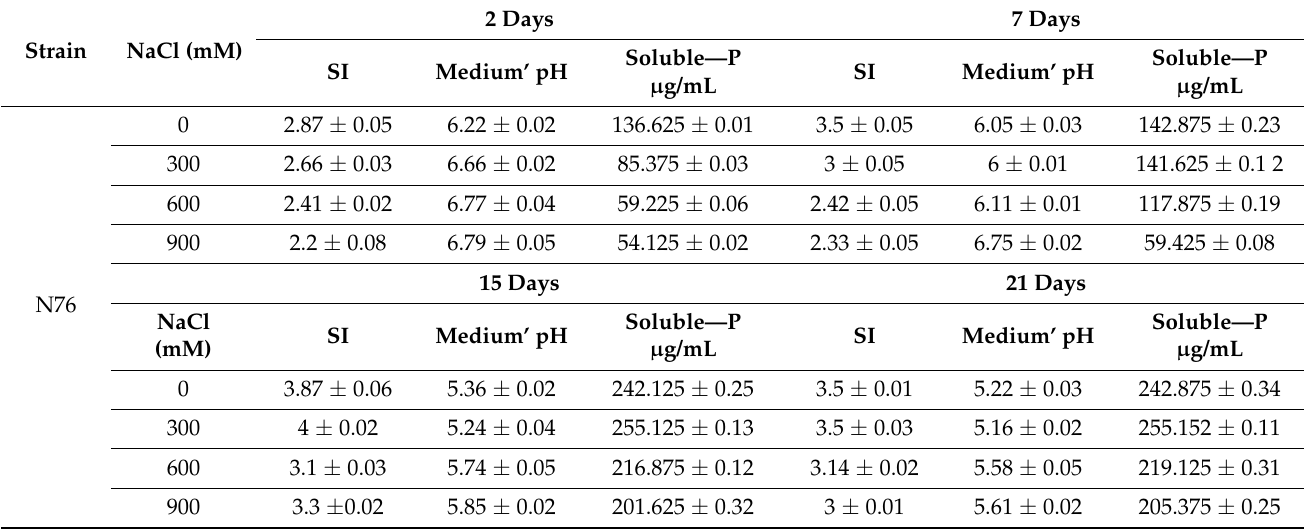
Table 1. Inorganic phosphorous solubilization by Pseudomonas azotoformans N76 on both solid and liquid